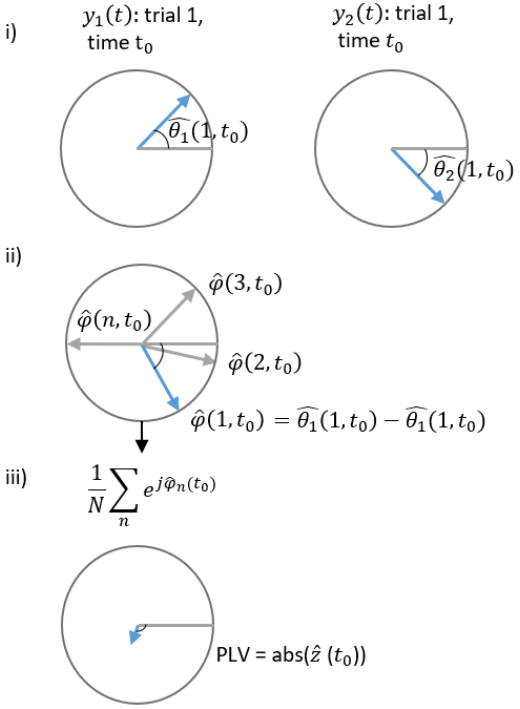
Figure 3. Uncorrelated signals and corresponding PLV. (i) phases of a single trial of two complex- value signals at t o , (ii) difference between phases for multiple trials is presented (iii) The resulting in complex PLV for the uncorrelated